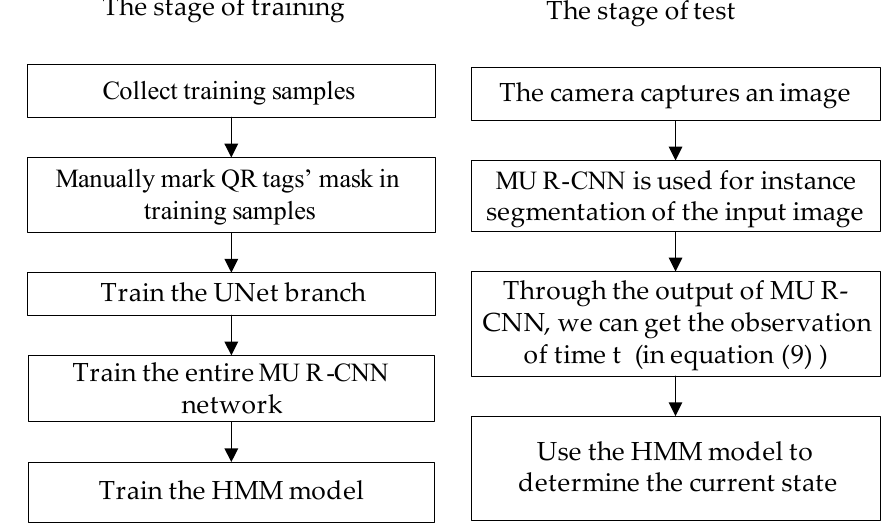
Figure 7. The system architecture of our QR tag instance segmentation and tracking.